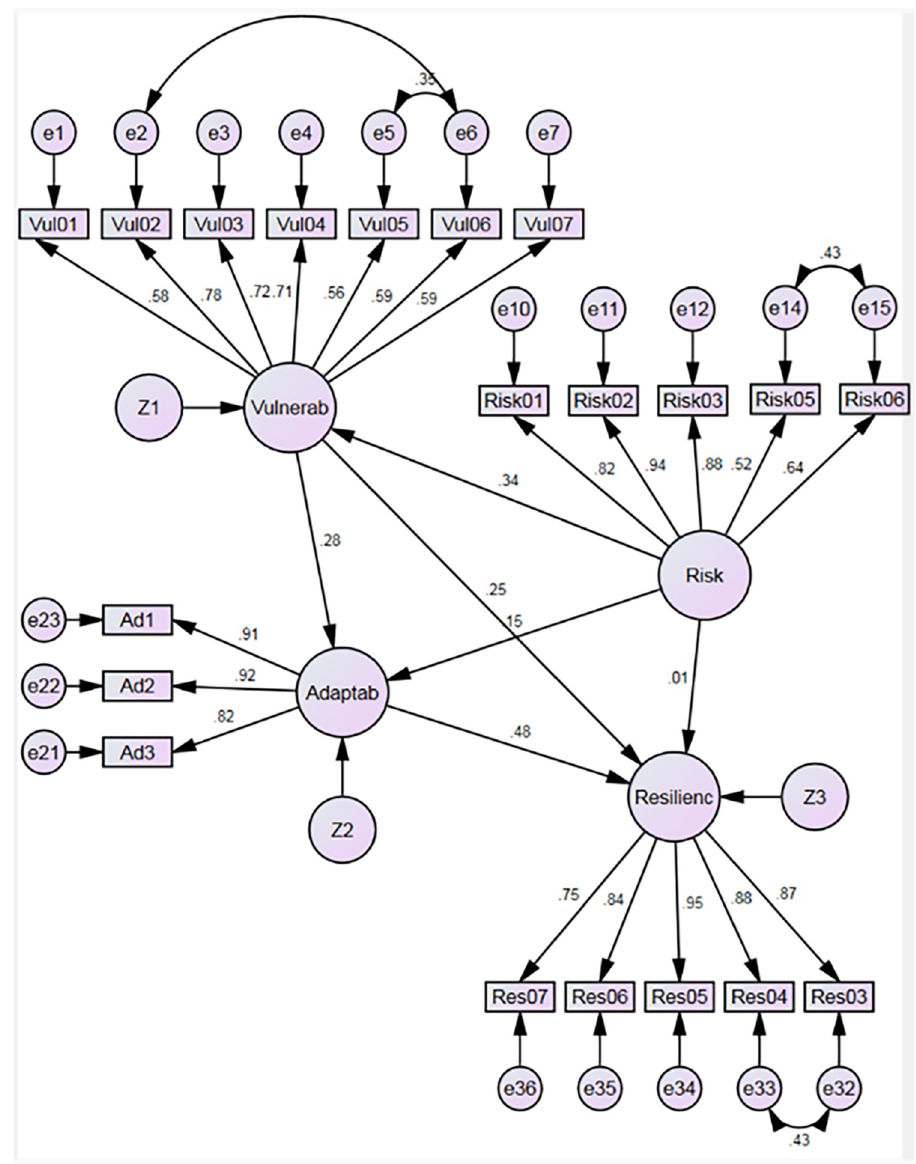
Fig 7. Results during pandemic. Source: By the authors